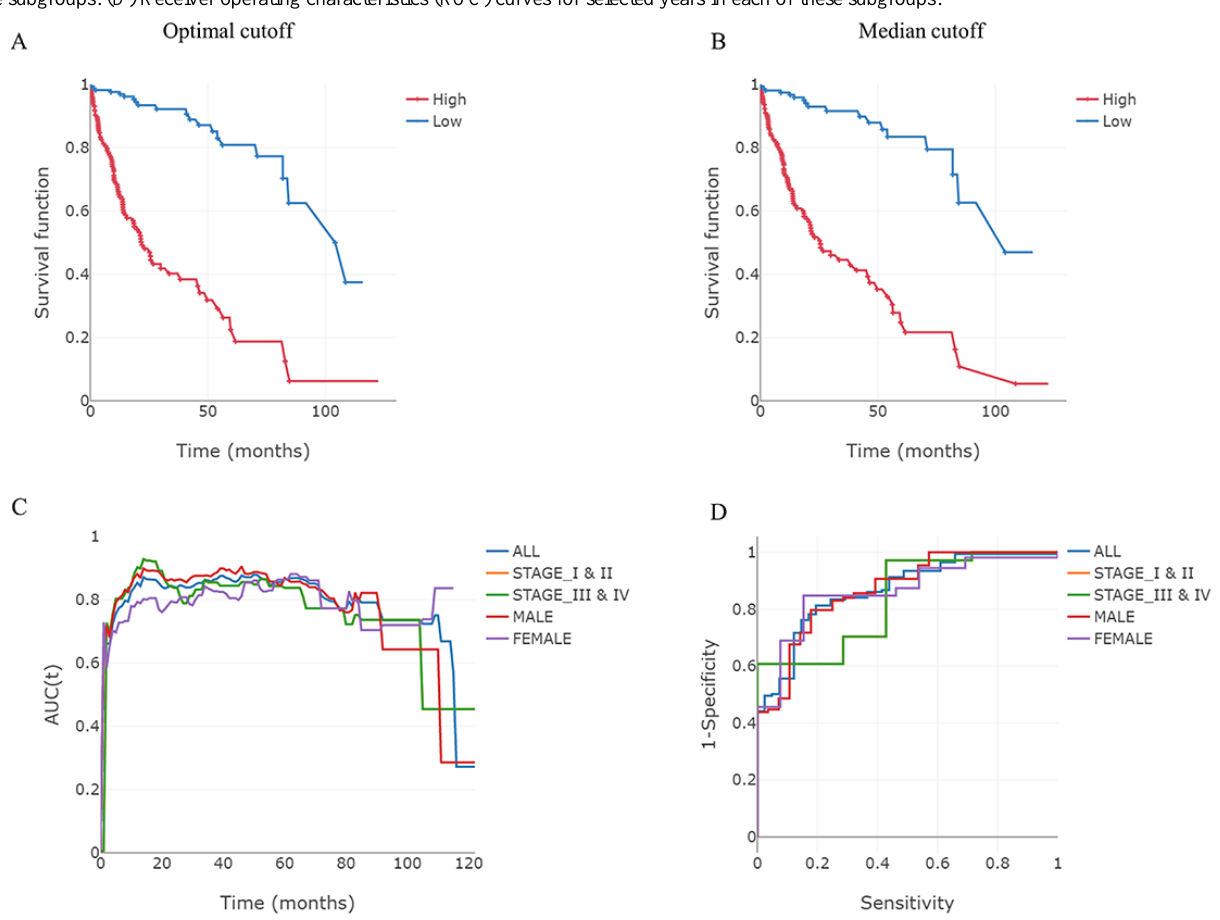
Figure 3. An example of survival analysis using a variable signature. Expression levels of genes were classified as either low or high (blue or red lines, respectively) based on a comparison of their optimal (A) and median cut-off values (B). (C) Time-dependent area under the curve (AUC) for each of the subgroups. (D) Receiver operating characteristics (ROC) curves for selected years in each of these